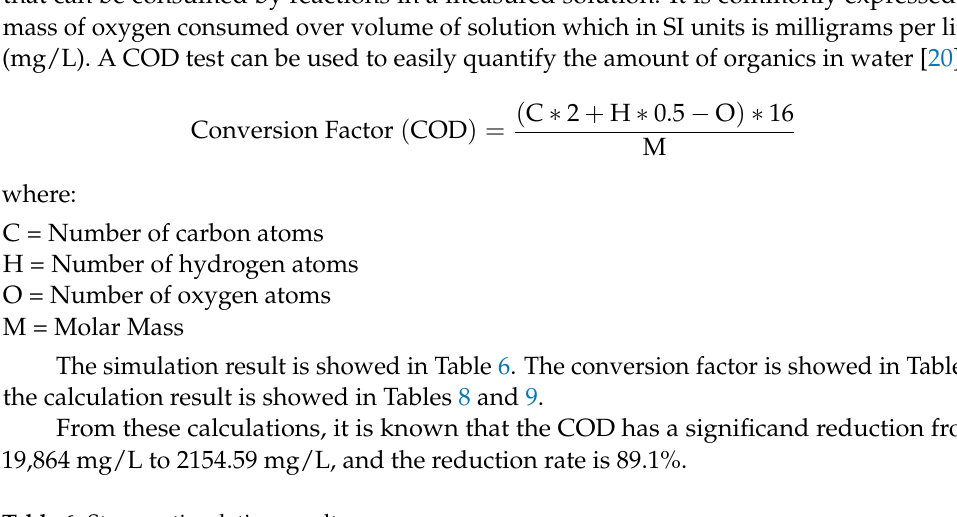
Table 6. Stream stimulation results.